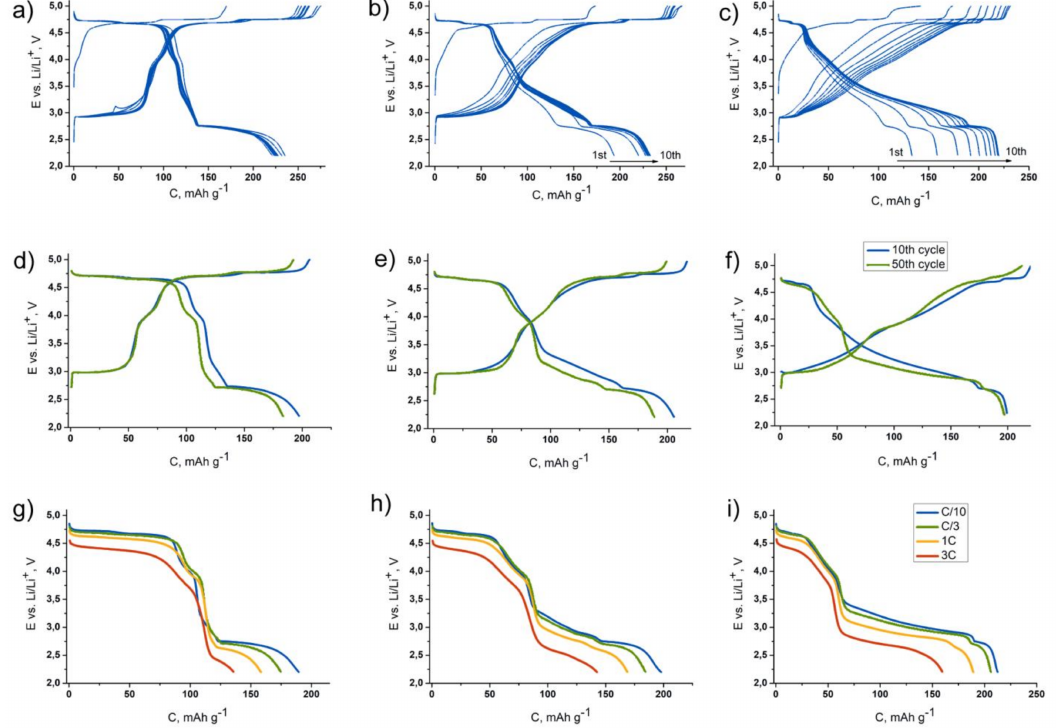
Figure 3. 1st–10th charge–discharge curves for the LiNi 0.5 Mn 1.5 O 4 ( a ), Li 1.5 Ni 0.5 Mn 1.5 O 4 ( b ) and Li 2 Ni 0.5 Mn 1.5 O 4 ( c ) sam- ples at C/10 rate; 10th and 50th charge–discharge curves for the same samples at C/3 rate ( d – f ); the discharge curves at C/10-3C rate for the same samples after cycling ( g – i